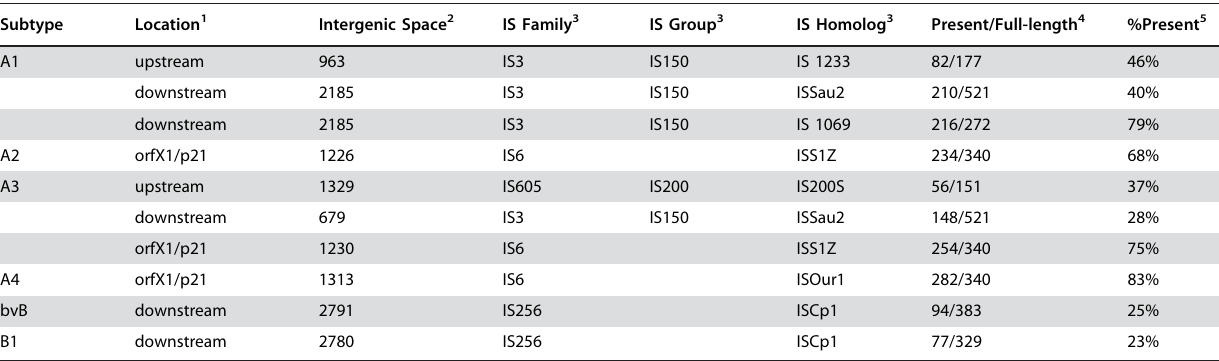
Table 2. Insertion sequence (IS) elements identified within intergenic and flanking regions of serotype A and B strains. .. ... .... ... ... .... ... ... .... ... ... .... ... ... .... ... ... .... ... ... .... ... ... .... ... ... .... ... ... .... ... ... .... ... ... .... ... ... .... ... ... .... ... ... .